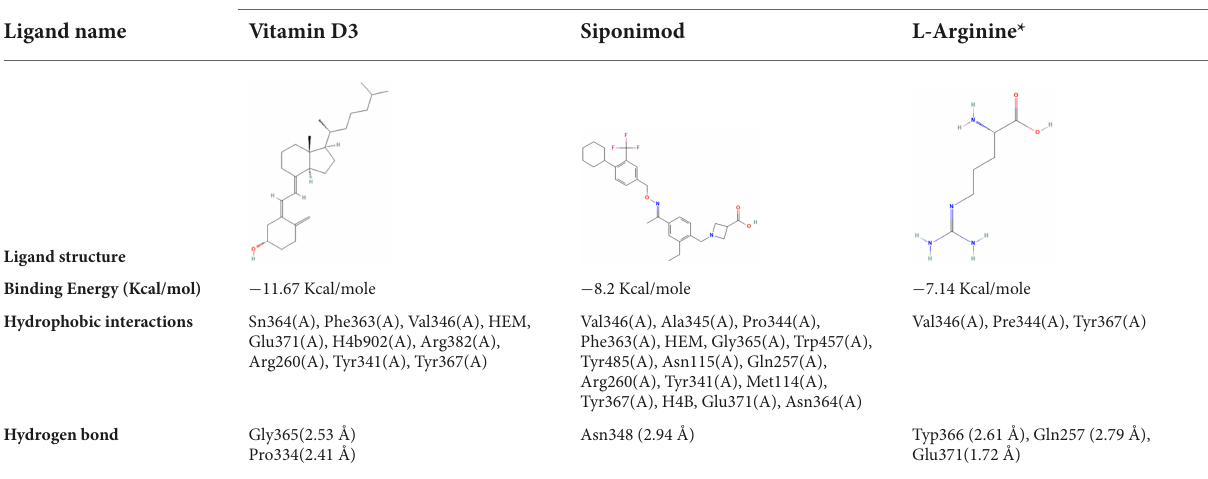
TABLE 2 Molecular docking score for the Vit D3, Sipo, and L-Arginine with iNOS